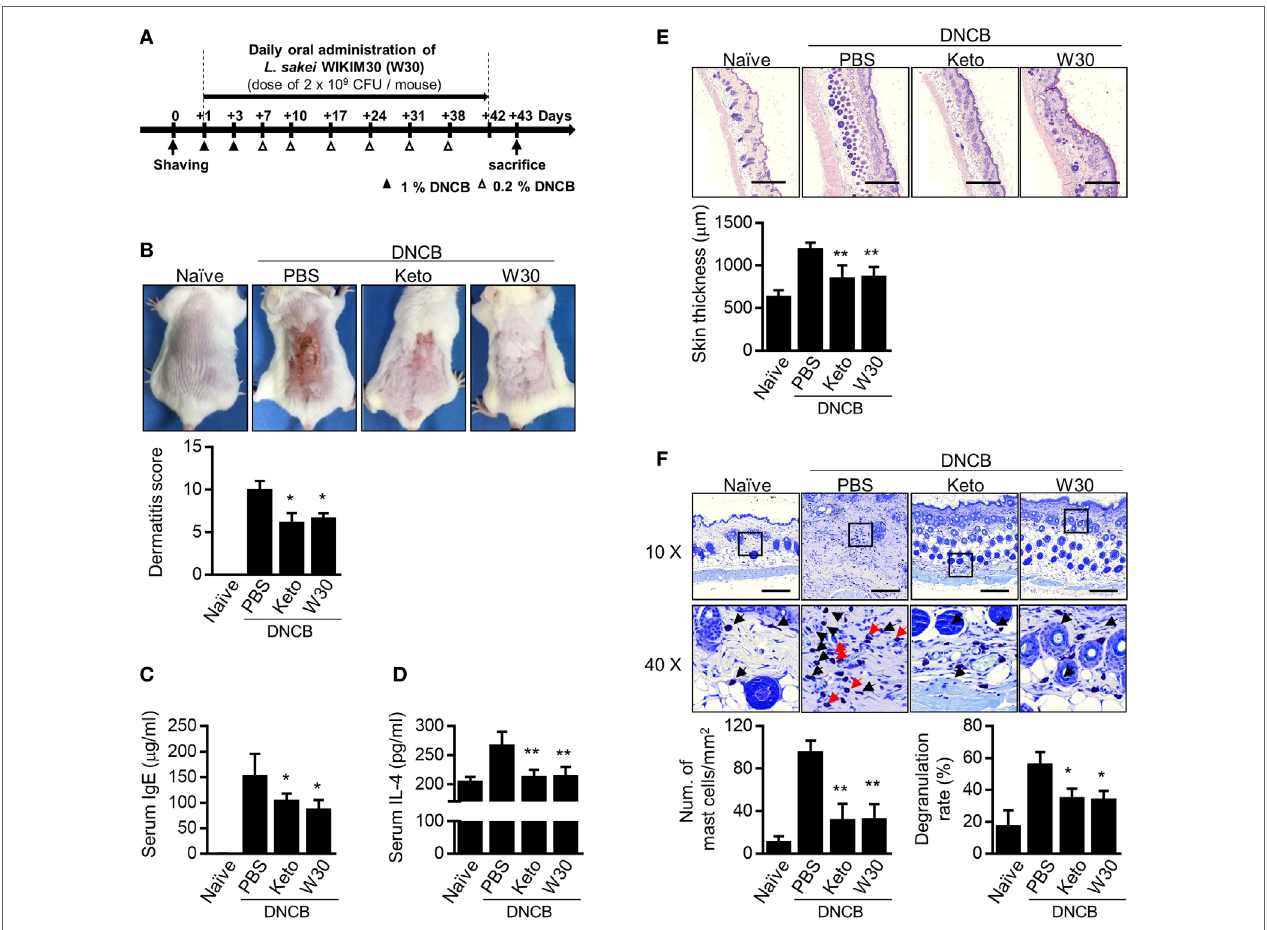
FigUre 2 | Oral administration of Lactobacillus sakei WIKIM30 ameliorates atopic dermatitis (AD)-like symptoms. (a) Experimental design. To induce AD-like immunologic features and skin lesions in mice, DNCB was applied to the dorsal skin. Phosphate-buffered saline (PBS), ketotifen, or L. sakei WIKIM30 was orally administered once daily for 6 weeks. (B) AD-like skin lesions were evaluated by visual observation. (c,D) Serum immunoglobulin (Ig)E and interleukin (IL)-4 levels were detected by sandwich enzyme-linked immunosorbent assay. (e,F) Dorsal skin sections were stained with hematoxylin and eosin or Toluidine Blue.